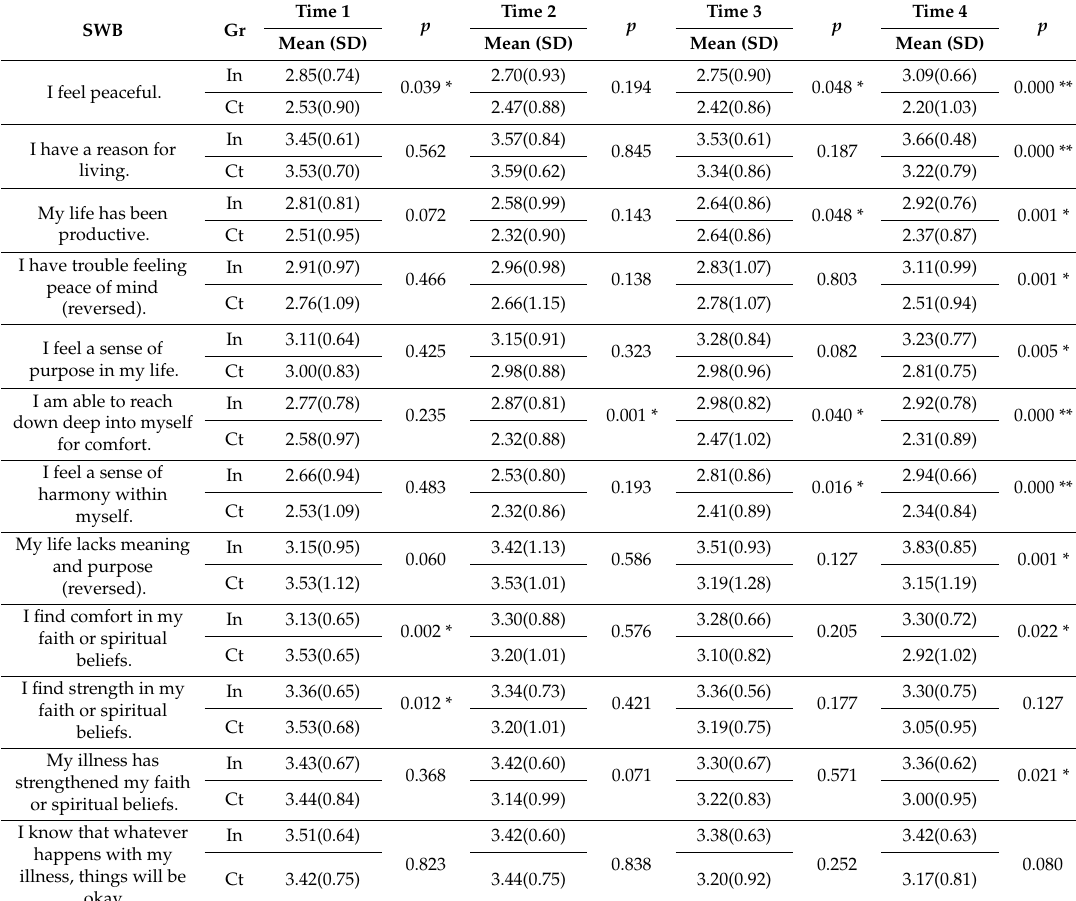
Table 3. The mean scores of spiritual well-being of the intervention (n = 53) group and the control group (n = 59) at Time 1, Time 2, Time 3 and Time